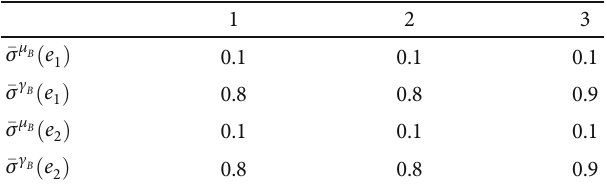
Table 27: Upper approximation of B .